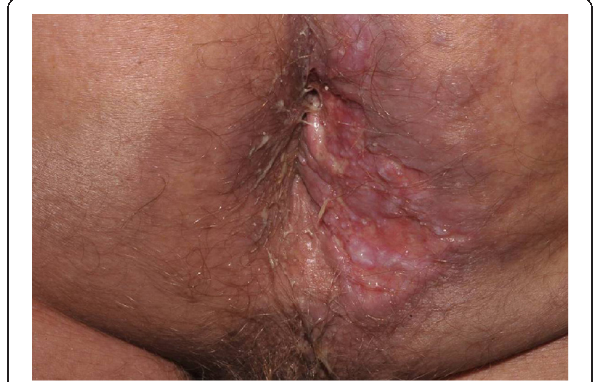
Figure 5 Cutaneous tuberculosis: phagedenic perianal ulcer showing worsening of the perianal ulcer after treatment for leprosy lesion, for two months.